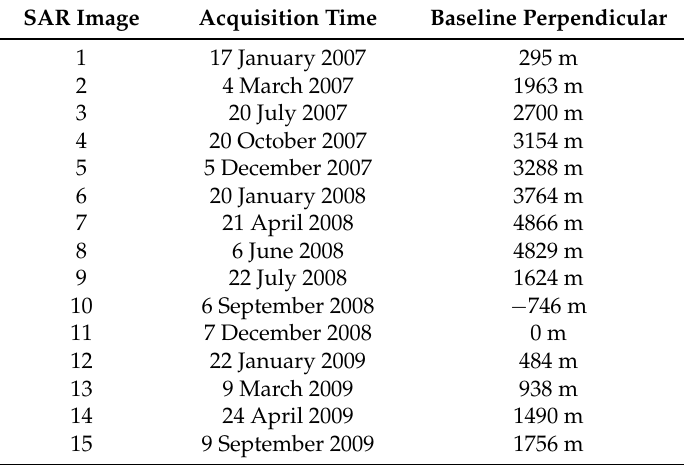
Table 3. ALOS/PALSAR archive with acquisition time and length of perpendicular baseline relative to the reference image on 7 December